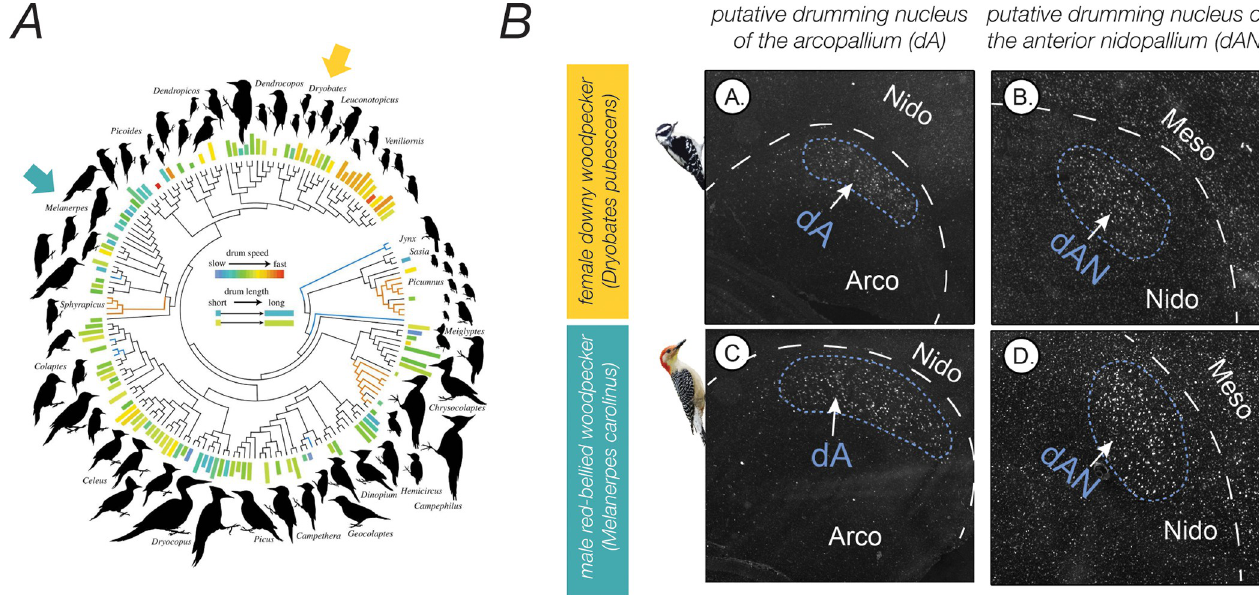
Fig 1. Drumming behaviour and expression of parvalbumin neurons in the forebrain of woodpeckers. (A) Phylogeny and species diversity of drumming in woodpeckers. Height of bars next to bird silhouettes summarises the duration of drums for individual species, and the colour of the bars indicates drumming speed for each species. Yellow and blue arrows highlight birds depicted in B. Adapted from [7]. (B) Clusters of parvalbumin neurons in 2 forebrain areas (the “dA” and “dAN”) of 2 woodpecker species. Adapted from [6].